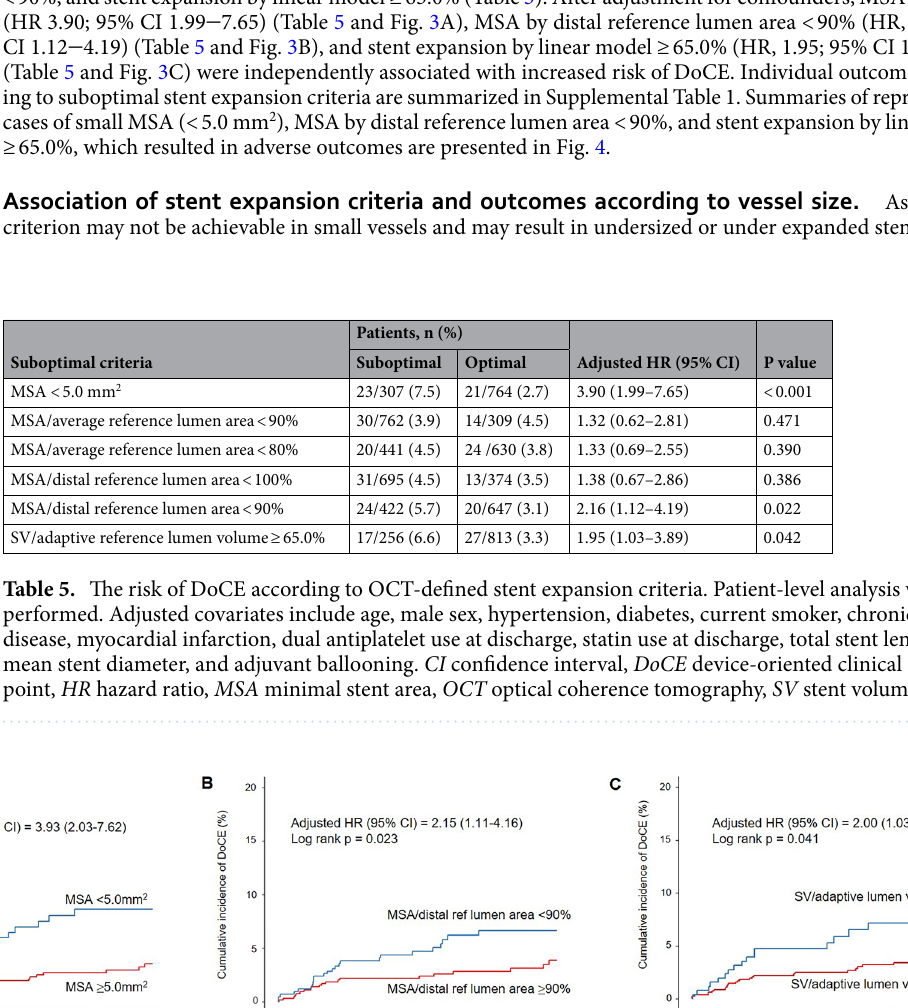
Figure 3. Kaplan–Meier curves according to OCT-defined suboptimal stent expansion criteria. Kaplan–Meier estimates for DoCE according to ( A ) MSA (< 5.0 mm 2 versus ≥ 5.0 mm 2 ), ( B ) MSA/distal reference lumen area (< 90% versus ≥ 90%), and ( C ) SV/adaptive reference volume (≥ 65.0% versus < 65.0%) Adjusted covariates include age, male sex, hypertension, diabetes, current smoker, chronic kidney disease, myocardial infarction, statin use at discharge, stent diameter, and total stent length. CI confidence interval, DoCE device-oriented clinical end point, HR hazard ratio, MSA minimal stent area, OCT optical coherence tomography, SV stent